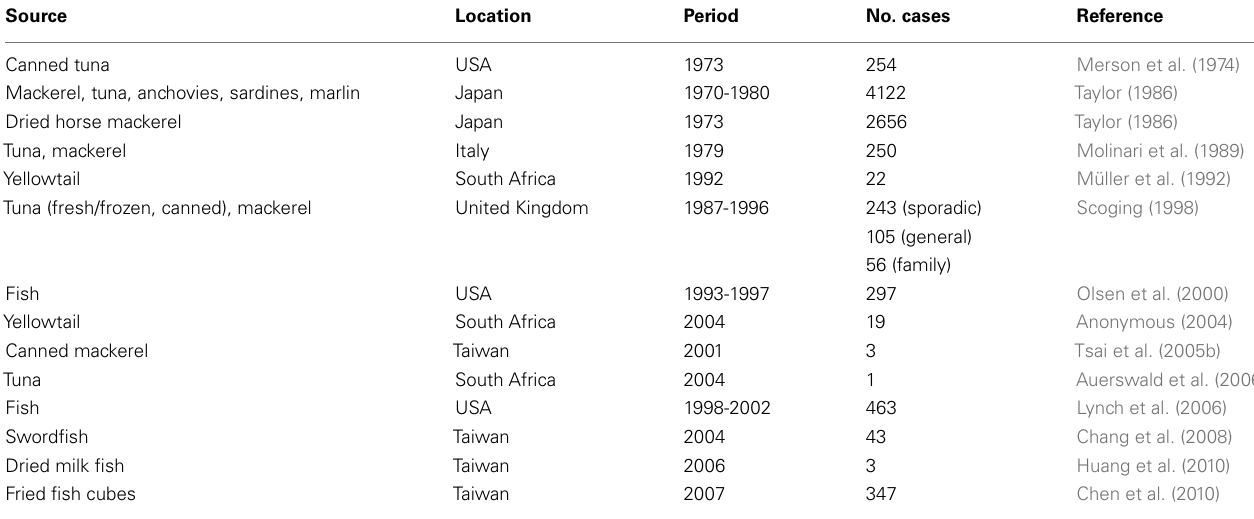
Table 4 | Outbreaks of scombroid poisoning: source, geographical location, period, and number of involved